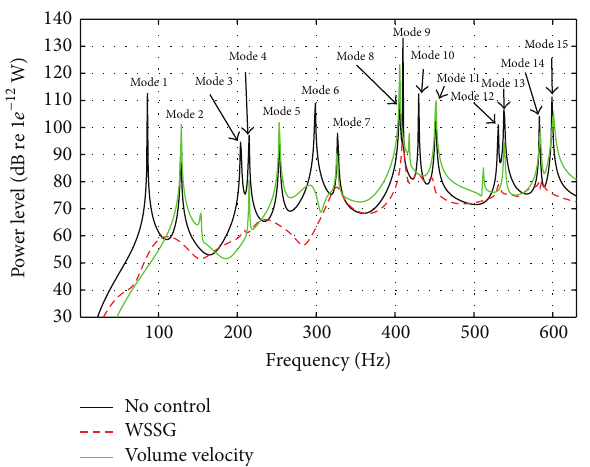
Figure 6: Simulated control of the clamped plate using WSSG and volume velocity as objective functions.